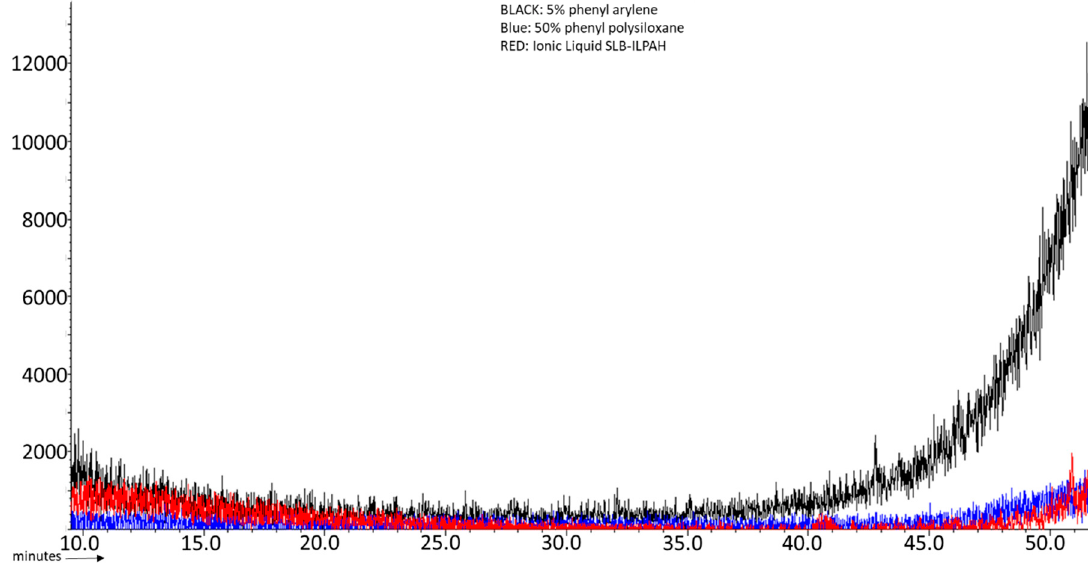
Figure 5. Bleeding of three columns (T max = 300): phenyl arylene (black), 50% phenyl-polysiloxane (blue) and SLB-ILPAH (red) stationary phases.